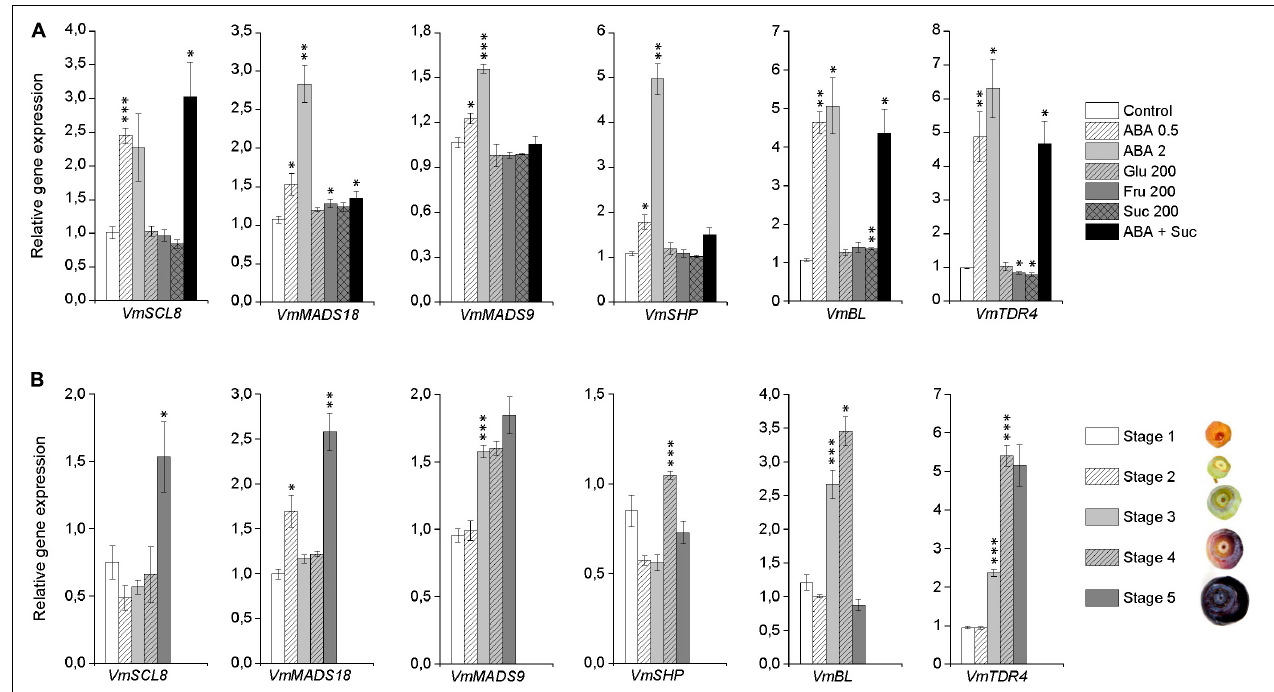
FIGURE 8 | Expression of potential ripening-related transcription factors (TFs) in response to post-harvest ABA and sugar treatments (A) and during bilberry fruit development (B) . The gene expression was analyzed 4 days after the beginning of the treatments. The treatments were: ABA (0.5 and 2 mM), glucose (200 mM), fructose (200 mM), sucrose (200 mM), 0.5 mM ABA + 200 mM sucrose, or water (control). Relative expression of the genes was quantified by qRT-PCR and normalized to VmGAPDH . Values in (A) represent means ± SEs of three replicates and asterisks significant differences from control in Student’s t -Test ( ∗ P ≤ 0.05, ∗∗ P ≤ 0.01, ∗∗∗ P ≤ 0.001). Values in (B) represent means ± SEs of four replicates and asterisks significant increase from previous developmental stage in Student’s t -Test ( ∗ P ≤ 0.05, ∗∗ P ≤ 0.01, ∗∗∗ P ≤ 0.001). Stages 1–5 indicate the bilberry fruit developmental stages from flower to ripe